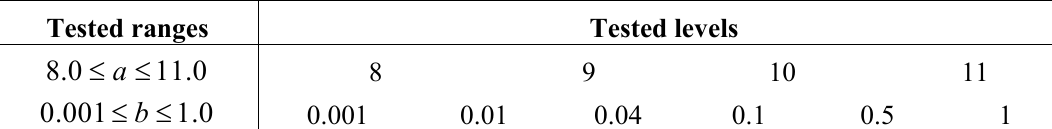
Table 3. Tested ranges and levels for a and b .